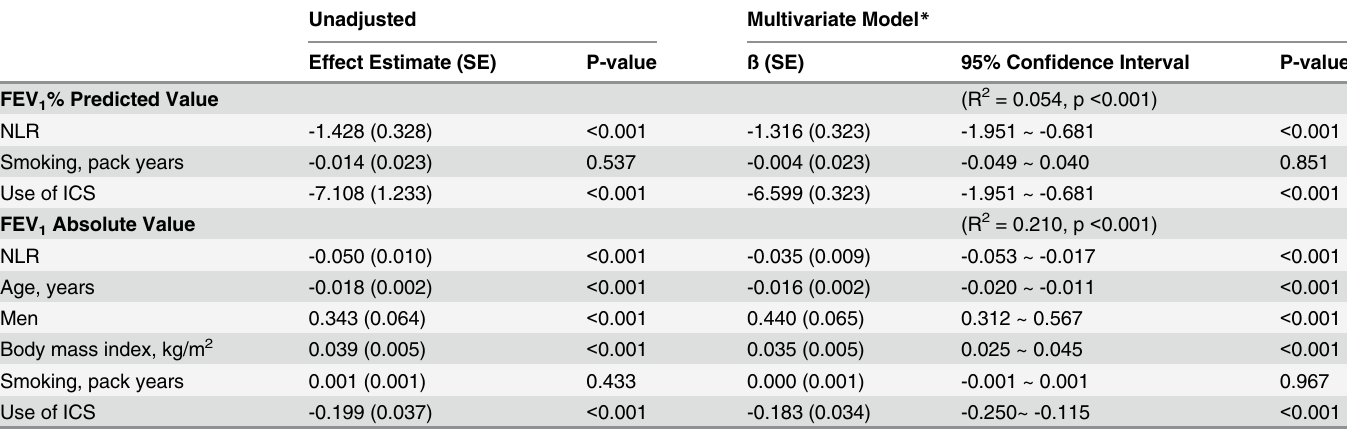
Table 2. Multivariate Linear Regression Analysis with FEV1 As the